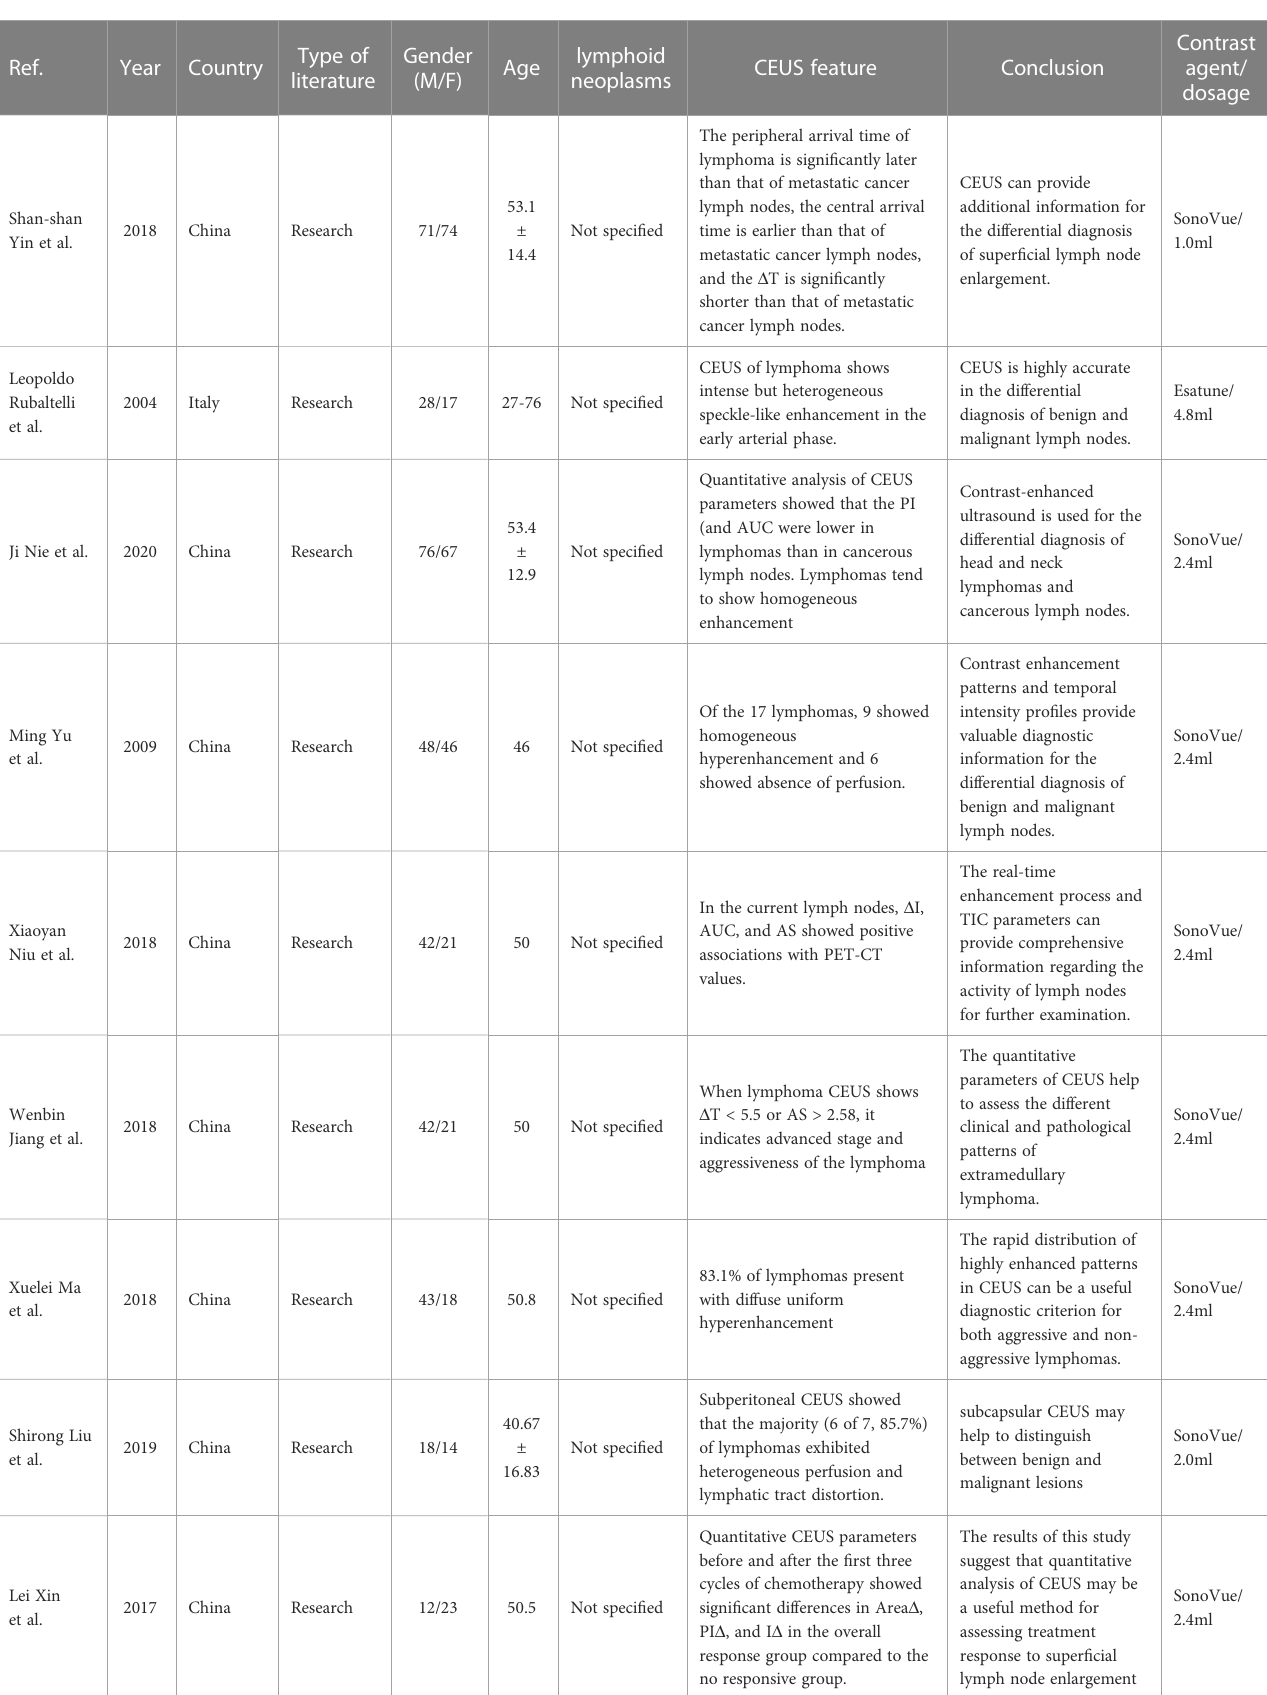
TABLE 1 Contrast-enhanced ultrasound characteristics of super fi cial lymph node lymphoma reported in the literature.